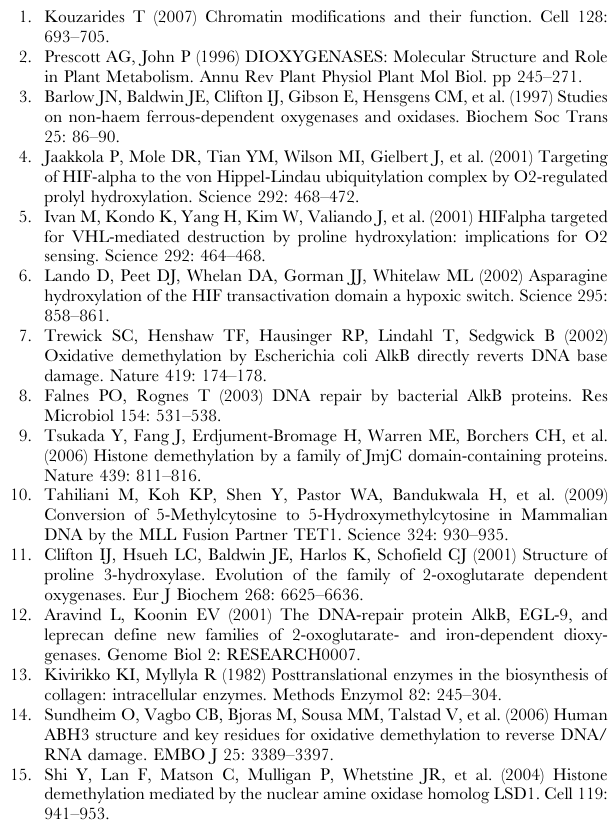
Table S3 Greater than 2 fold hypoxically down-regulat- ed genes in wt strain. Table S4 Greater than 2 fold hypoxically upregulated genes in Ofd2 deletion strain. Table S5 Greater than 2 fold hypoxically down-regulat- ed genes in Ofd2 deletion strain. Table S6 Information on the microarray target genes. Table S7 Peptide library. Table S8 Quantitative PCR primer